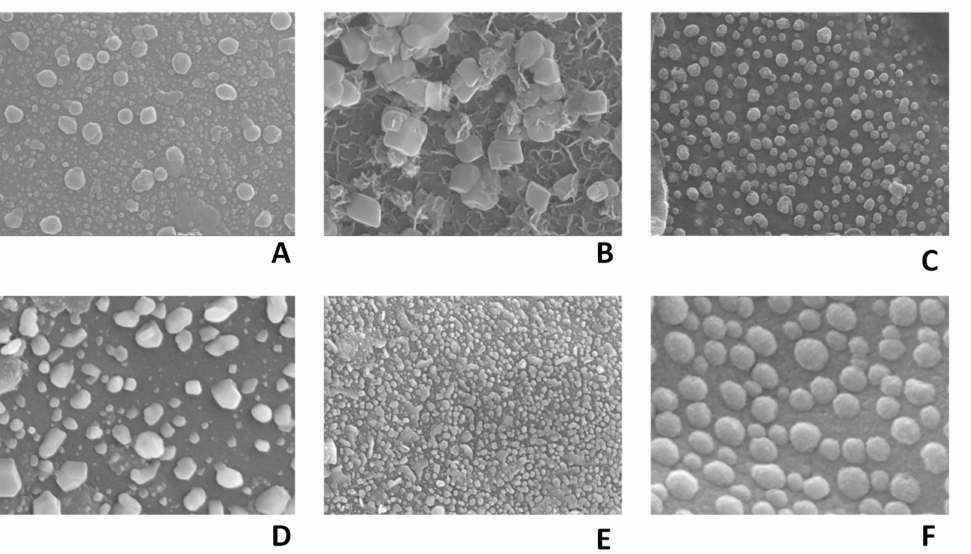
Figure 1. FESEM images of CNS500 (60 K × ) ( A ), CNS600 (50 K × ) ( B ), CNS700 (50 K × ) ( C ), CNS800